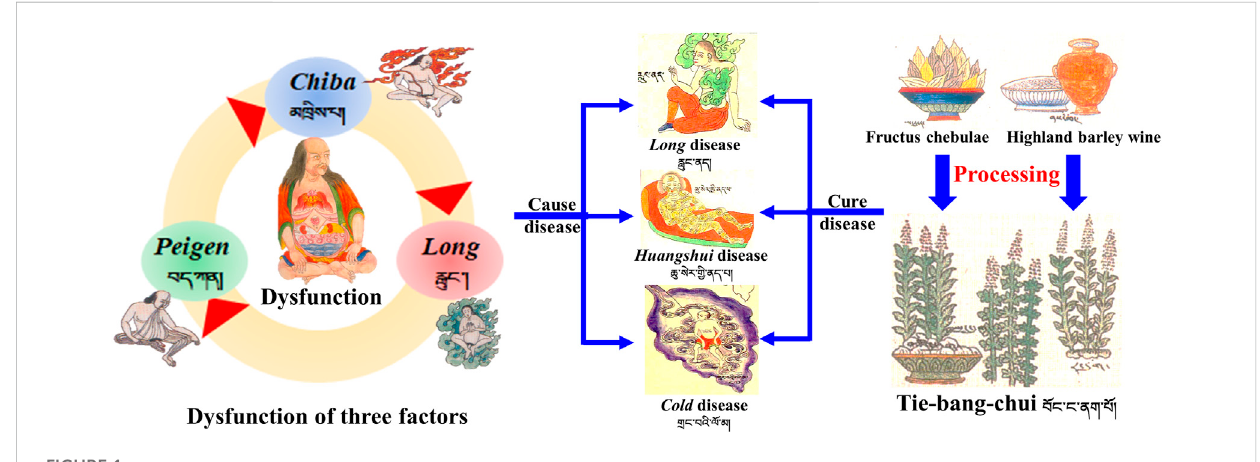
FIGURE 1 Traditional processing method of TBC in Tibetan